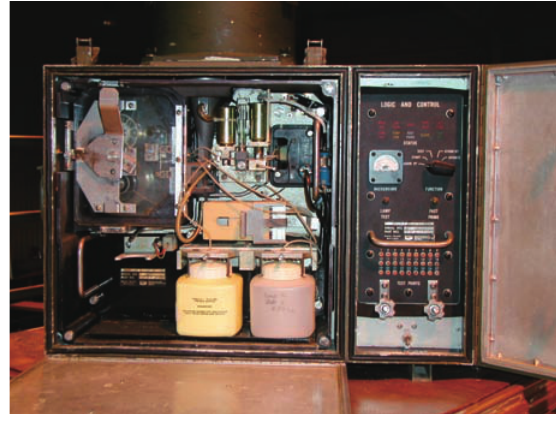
Fig. 3 The XM19 showing the particle impingement tape cassette and liquid chemistry